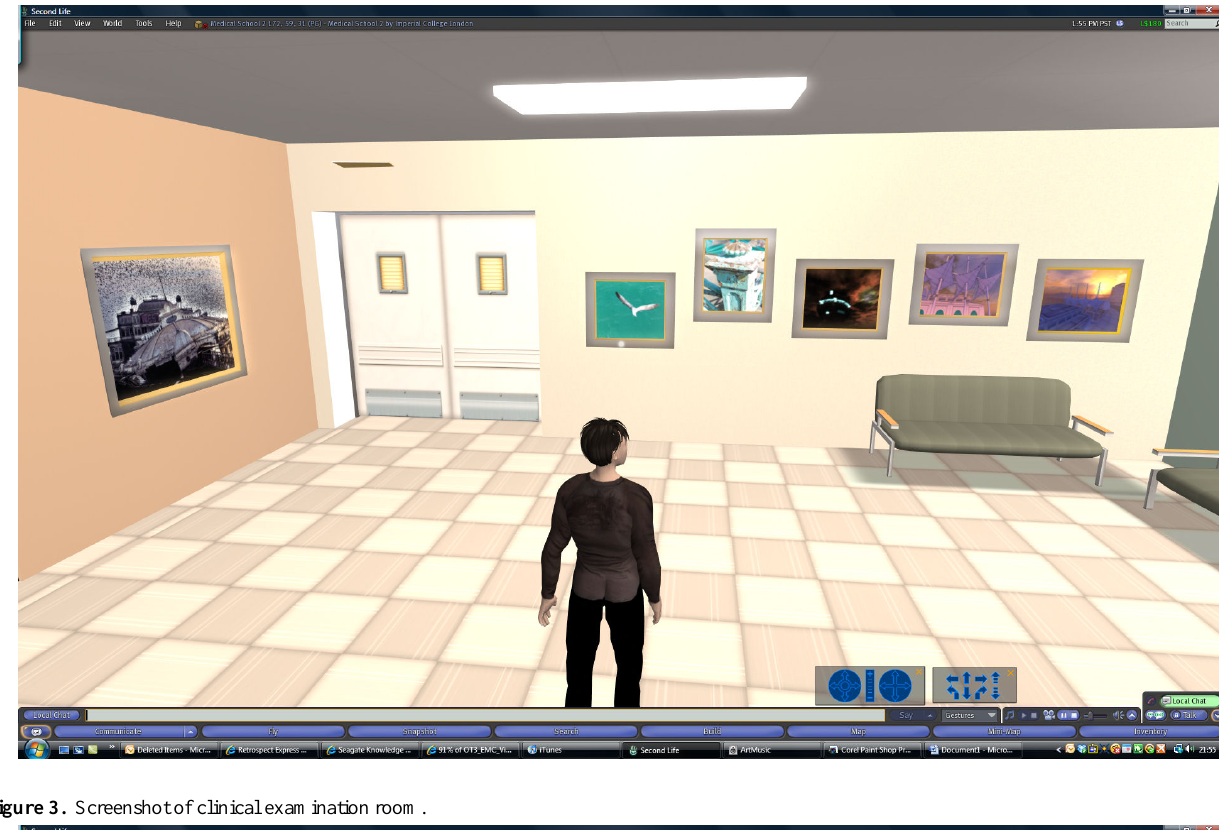
Figure 2. Screenshot of hospital waiting room.